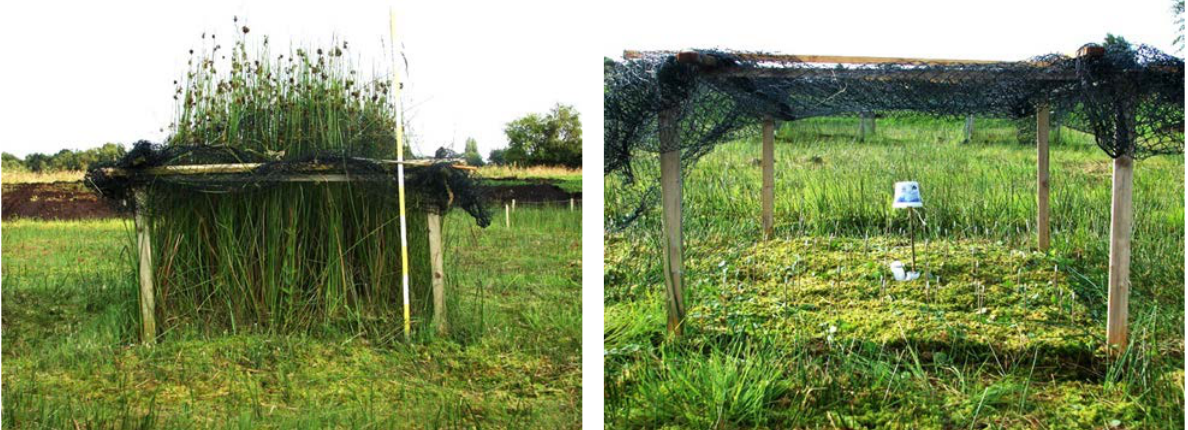
Figure 1. Permanent quadrats on the Sphagnum farming site in Rastede, autumn 2014: with vascular plants (left) and without vascular plants (right). Photos: Balázs